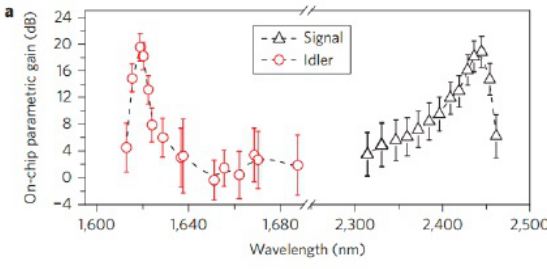
Fig. 17. Amplification and conversion eflciency of the silicon wave- length translator (see Figs. 15 and 16) as a function of the